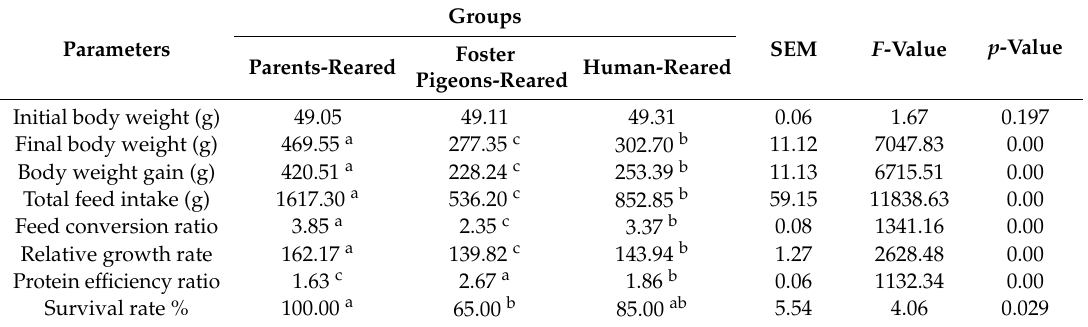
Table 5. E ff ect of di ff erent fostering methods on growth performance of squabs during brooding period.